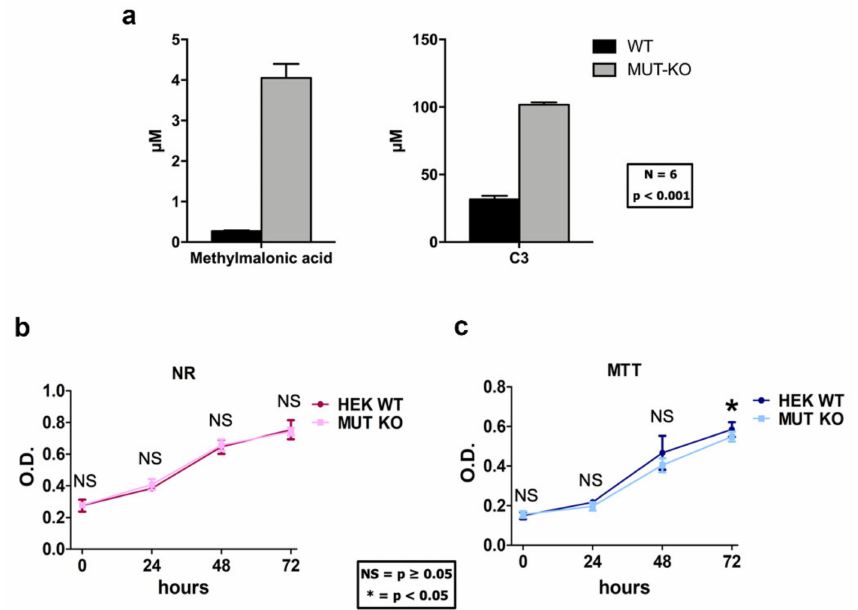
Figure 2. Measurement of methylmalonic acidemia (MMA) metabolites biomarkers and growth curves in HEK 293 cells after genome modification. ( a ) The levels of methylmalonic acid and propionylcarnitine (reported as C3) were measured by targeted LC-MS / MS. For both metabolites, significantly higher levels were detected in MUT-KO cells in comparison with WT ones. Concentrations were normalized to the protein content of each sample and reported as µ M. For each condition, six biological replicates were employed. Data are reported as mean ± standard error of the mean (SEM); a one-way two-tail t -test p -value for both comparisons is ≤ 0.001. WT and MUT-KO cells were analyzed by ( b ) Neutral-red (NR) and ( c ) MTT assays. Data are reported as mean values of three independent experimental replicates and error bars represent the standard deviation (SD). A one-way two-tail paired t -test was used to calculate the statistical significance of di ff erences between the tested cell types. OD: Optical density; *: p < 0.05; NS: Not significant ( p >